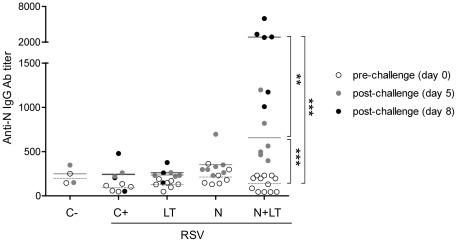
Neonatal N+LT nasal immunization primed for an early anti-N Ab response after the RSV challenge.Mice vaccinated as neonates as in Fig.1 were bled before (day 0) and 5 or 8 days after the viral challenge with hRSV-A2 (d5 or d8 p.i.). Serum anti-N antibody titers were assessed by an endpoint dilution ELISA assay on plates coated with N using HRPO-conjugated rabbit anti-mouse Ig(H+L) Abs. Individual titers and the mean titer for day 0 (white circles, dotted line), d5 p.i. (grey circles, plain line) and d8 p.i. (black circles, plain line) are figured. Man-Whitney U-test was used for comparison of titers at day 0, 5 and 8 p.i. for each group (** p<0.01; *** p<0.001).